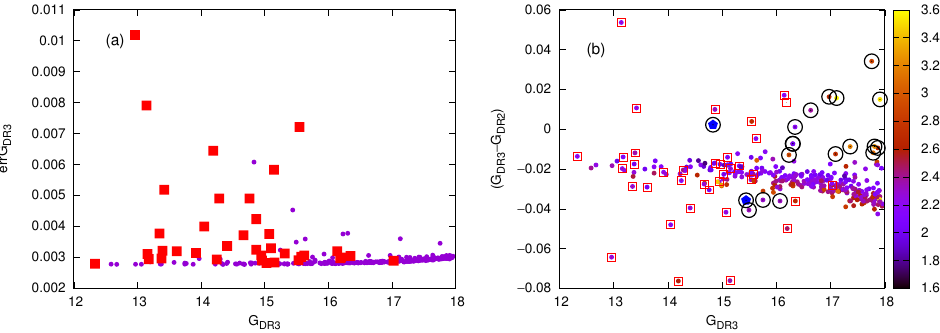
Figure 3. ( a ) The same as Figure 1a for the cluster NGC 7419. ( b ) The same plot as Figure 1b, but the color coding corresponds to the color (B G − R G ). The blue symbols indicate